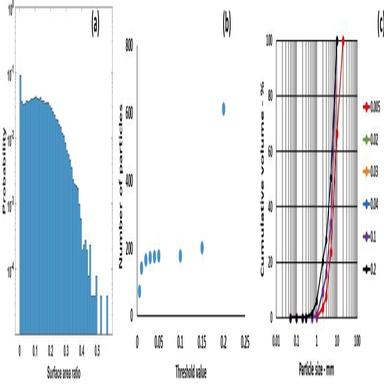
(a) histogram of all surface area ratios; (b) number of particles resulted from particle separation as a function of threshold value for surface are ratio; (c) a comparison of particle size distribution curves obtained from different threshold values.